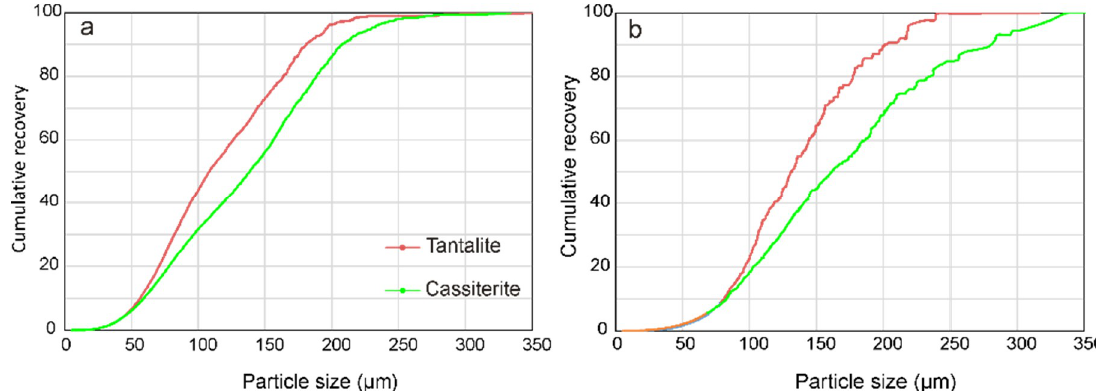
Figure 13. Cumulative recovery of CGM and cassiterite according to the particle size distribution determined by MLA in Penouta concentrates; ( a ) from leucogranite; and ( b ) from tailings.